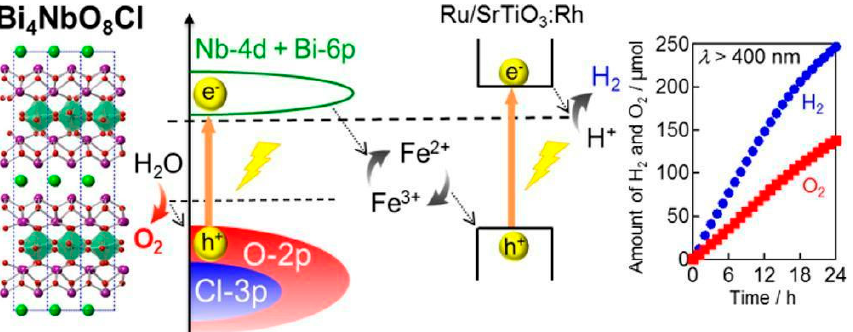
Figure 9. Scheme of Z-scheme water splitting of Bi 4 NbO 8 Cl coupled with Ru/SrTiO 3 /Rh photocatalyst via Fe 3+ /Fe 2+ redox mediator. Reprinted with permission from the authors of [58]. Copyright (2019) American Chemical Society, Washington, DC, USA.